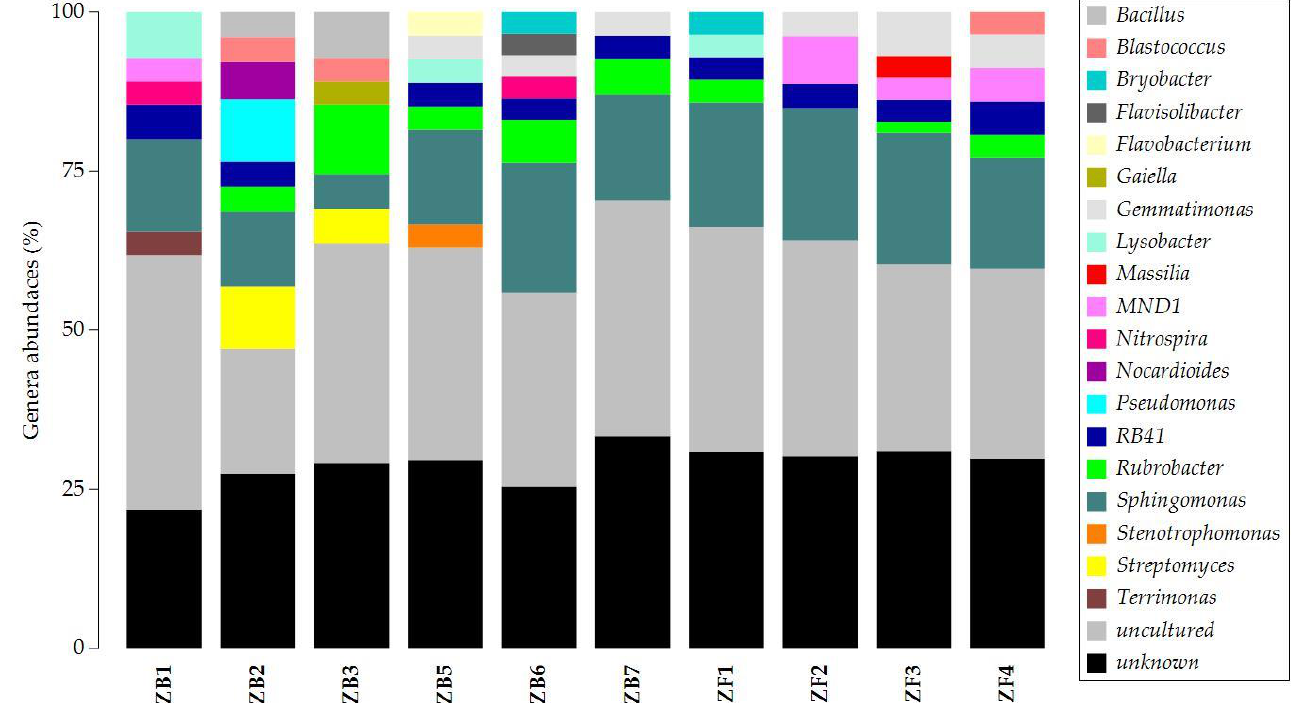
Figure 3. Taxonomic bar plot of the relative abundances of bacterial genera associated with individ- ual soil samples. soil